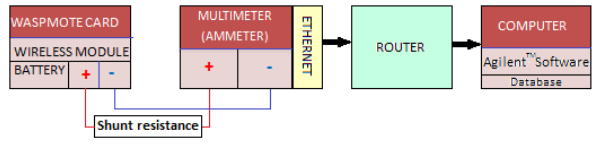
Figure 1. Acquisition and storage of the current consumption in each node.